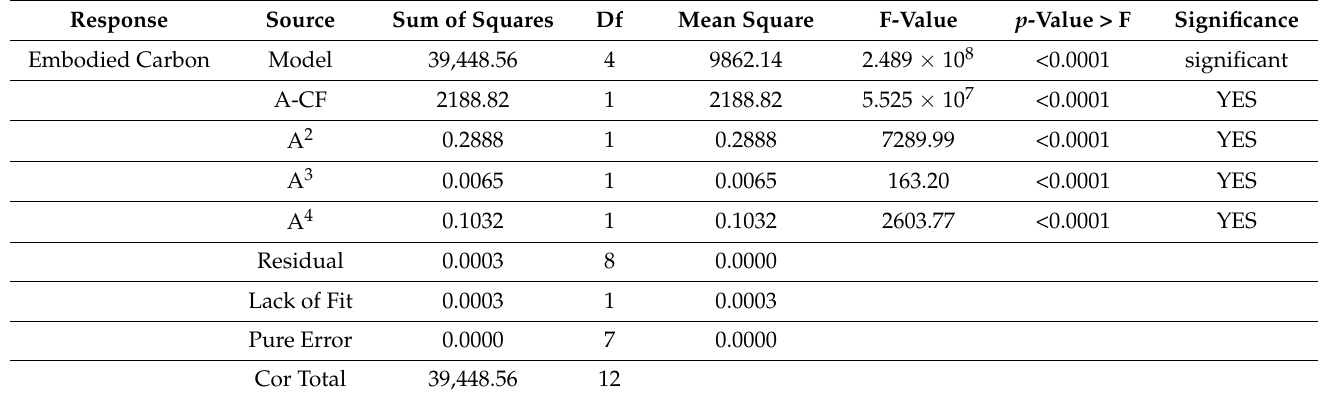
Table 10. ANOVA Results for the Variable Response 28-day Embodied Carbon.